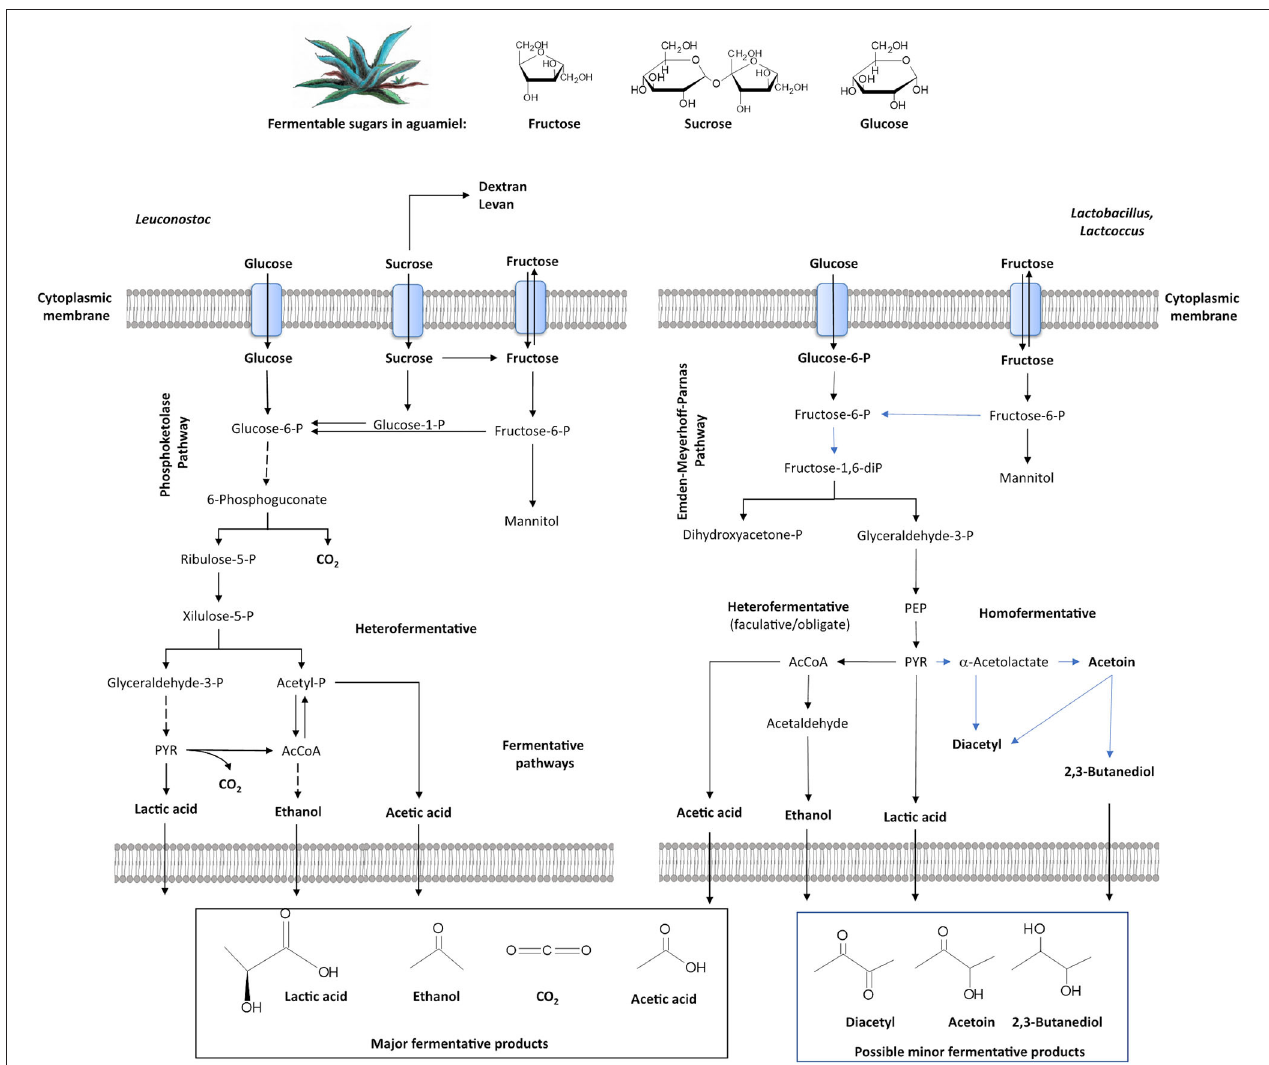
FIGURE 5 | Schematic representation of key metabolic pathways from the possible microbial essential core for pulque fermentation: The role of Leuconostoc, Lactobacillus, and Lactococcus . PEP, phosphoenolpyruvate; PYR, pyruvate. Sugar transporter systems are shown as blue structures in the cytoplasmic membrane. Continue arrows represent single metabolic enzyme-catalyzed reactions. Dotted lines represent several enzymatic reactions. Adapted from Dols et al. (1997), Melchiorsen et al. (2001), Zotta et al. (2017), Chacón-Vargas et al. (2020), Rocha-Arriaga et al. (2020), and Carvalheira et al. (2021).